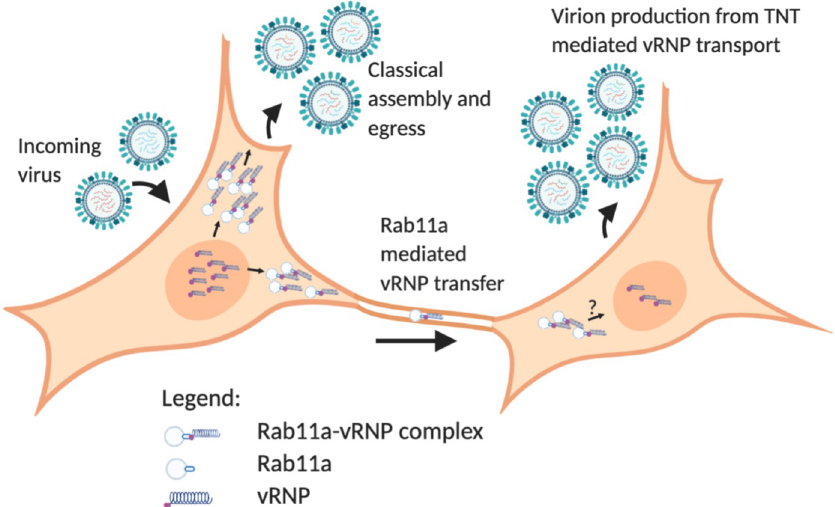
Fig 8. Working model for Rab11a mediated vRNP transport across TNTs. vRNP complexes synthesized within the nucleus are exported out and form Rab11a-vRNP complexes. Two potential fates of these complexes are shown- the classical assembly and egress pathway for production of progeny virions and transport of these complexes via TNTs to an uninfected cell. A new infection is initiated in the recipient cell, resulting in progeny virion production. Generated via